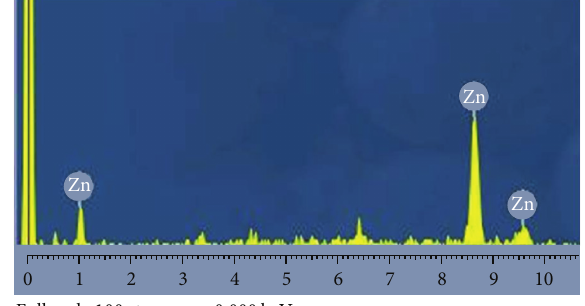
Figure 9: Energy-dispersive X-ray spectrum composition analysis of local region.